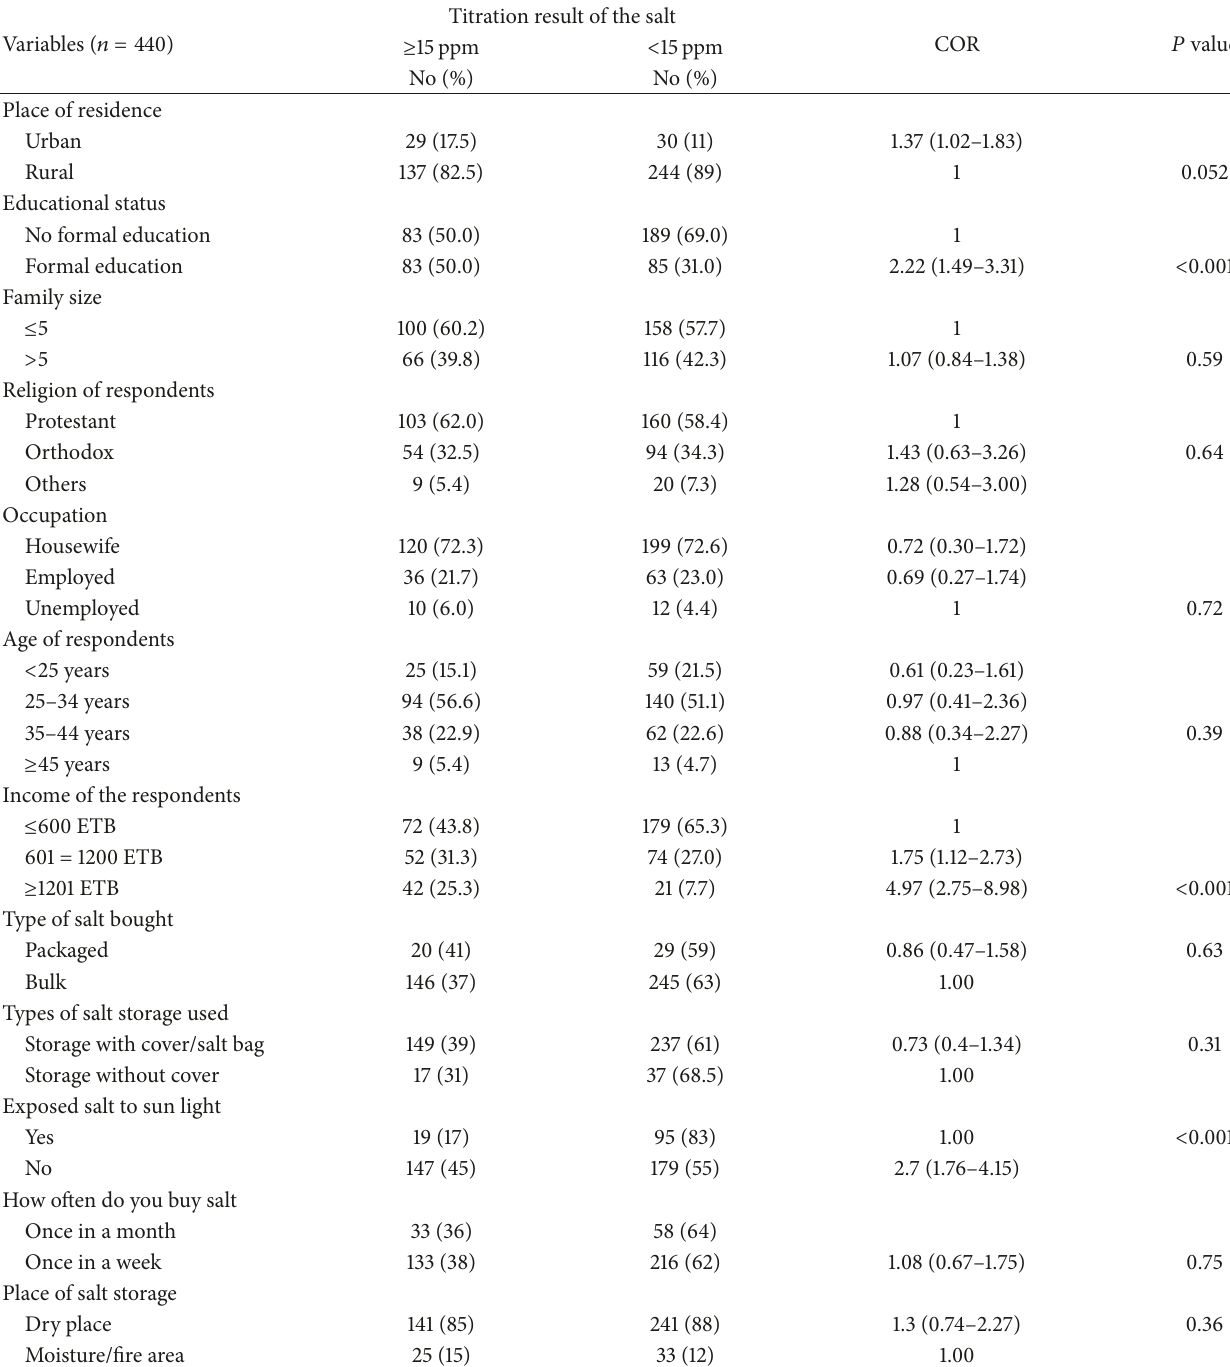
Table 4: Sociodemographic and practices factors associated with the presence of adequately iodized salt at home in binary logistic regression, Wolaita Sodo town and its peripheries, Southern Ethiopia